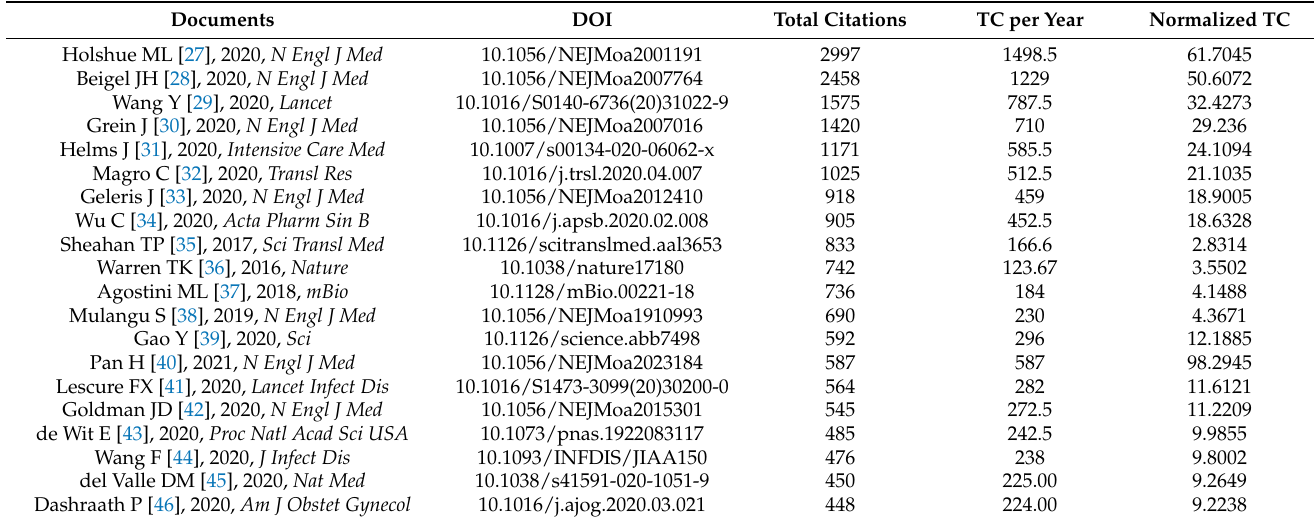
Table 3. Top 20 most frequently globally cited